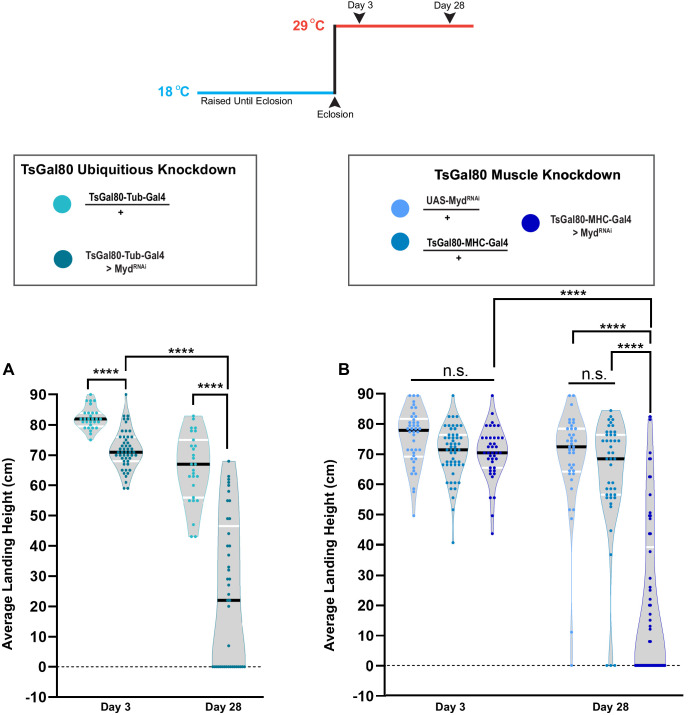
Adult-specific knockdown of UAS-mydRNAi.(A–B) Transient knockdown of myd with UAS-Dicer-2 using Tubulin-Gal4 (A) as well as MHC-Gal4 (B) using a temperature-sensitive Gal80 to repress Gal4 expression until after eclosion. Flies were kept at 18°C until eclosion, then shifted to 29°C. Flight performance was measured at both Day 3 and Day 28. The average landing height (cm) and sample size (n) for panel A for each condition: TsGal80,Tub-Gal4/+ Day 3 82.2 cm, n = 29, TsGal80-Tub-Gal4 > mydRNAi Day 3 66.7 cm, n = 28, TsGal80,Tub-Gal4/+ Day 28 71.7 cm, n = 50, and TsGal80-Tub-Gal4 > mydRNAi Day 28 24.1 cm, n = 41. For B, the average landing height (cm) and sample size (n) for each group are: UAS-mydRNAi /+ Day 3. 71.2 cm, n = 53, TsGal80,MHC-Gal4/+ Day 3 76.1 cm, n = 42, TsGal80,MHC-Gal4 > mydRNAi Day 3 70.7 cm, n = 40, UAS-mydRNAi /+ Day 28 63.5 cm, n = 43, TsGal80,MHC-Gal4/+ Day 28 68.8 cm, n = 38, and TsGal80,MHC-Gal4 > mydRNAi Day 28 18.9 cm, n = 58. Black bars represent median values. ****, p-value<0.0001 using Brown-Forsythe and Welch ANOVA tests with Post hoc Dunnett’s multiple comparisons. N.S. = Not Significant.
Figure 4—figure supplement 3—source data 1.Raw data for Figure 4—figure supplement 3.